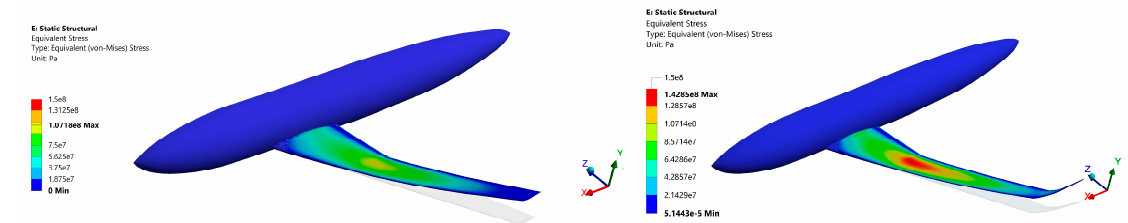
Figure 21. An example of 34% growth of maximum DLR-F4 wing spanwise stress due to the installation of a winglet with a large cant angle ѱ = 75°. High subsonic air flow regime: М = 0.8, α =1°.